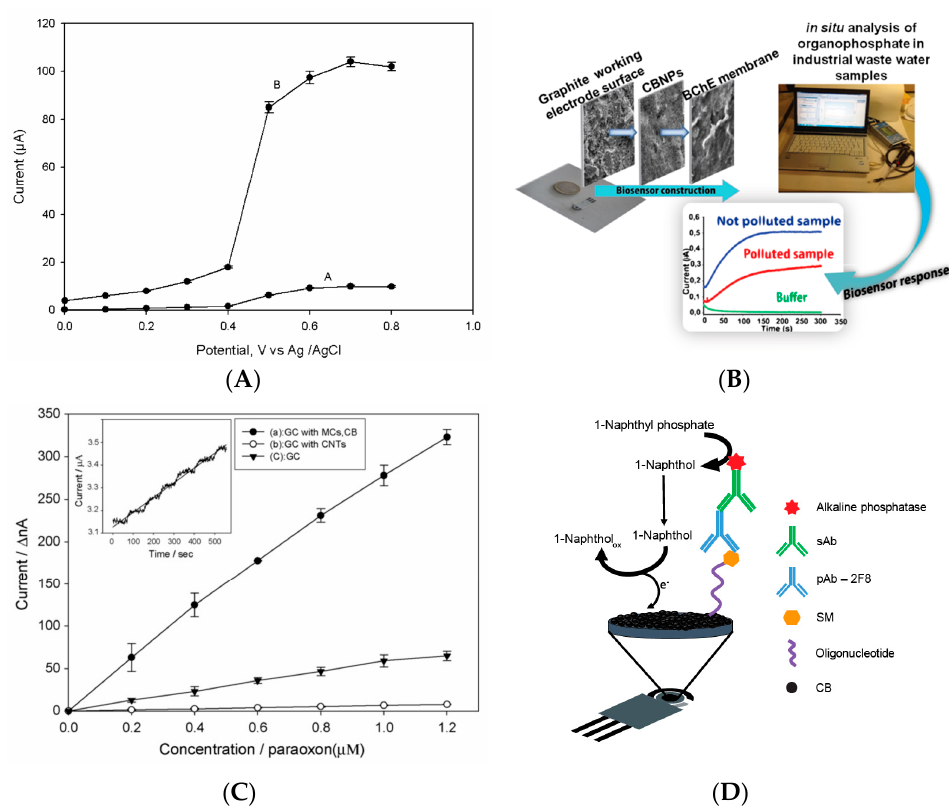
Figure 2. Biosensors based on nanomaterials for chemical warfare agent detection. ( A ) Study of applied potential using bare (A) and carbon nanotubes (B) modified electrode for the enzymatic by- product thiocholine [7]. ( B ) Miniaturised biosensor based on carbon black for the detection of model organophosphate nerve agent paraoxon [19]. ( C ) Paraoxon detection using a mesoporous-carbon black biosensor and organophosphorus hydrolase as the biocomponent [20]. ( D ) The scheme of carbon black-based heterogeneous oligonucleotide-antibody assay for sulphur mustard detection [21].